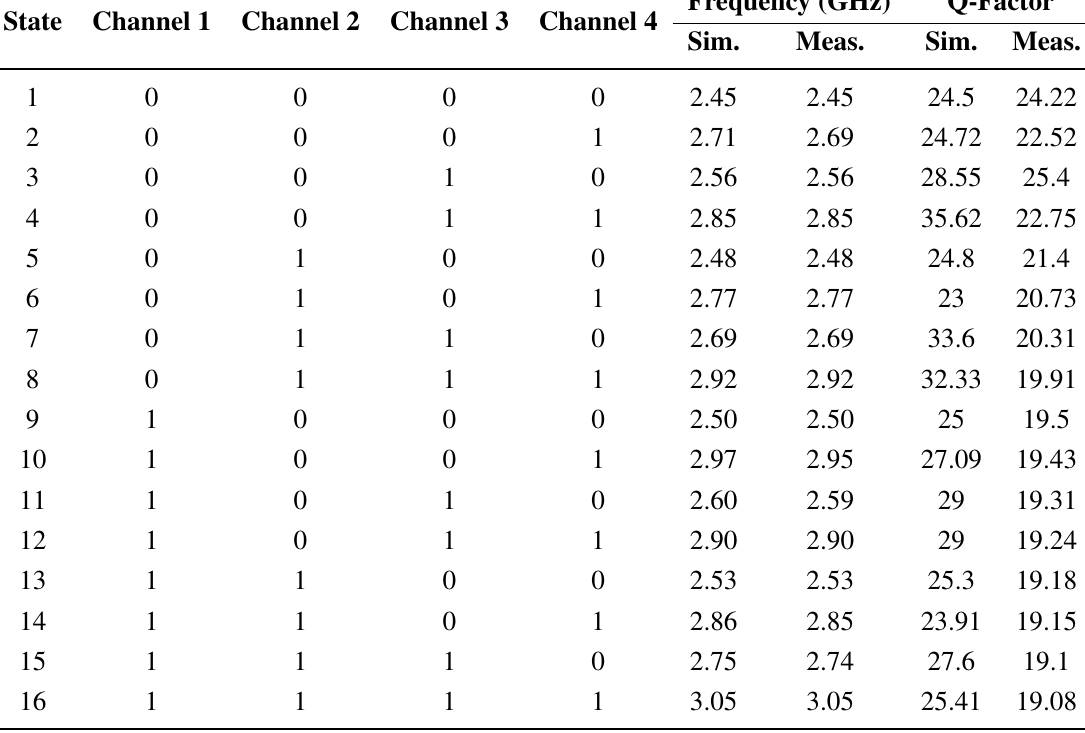
Table 3. Comparison of simulated and measured resonant frequencies and Q-factors of 16 liquid metal injecting states of the proposed SIW resonator.